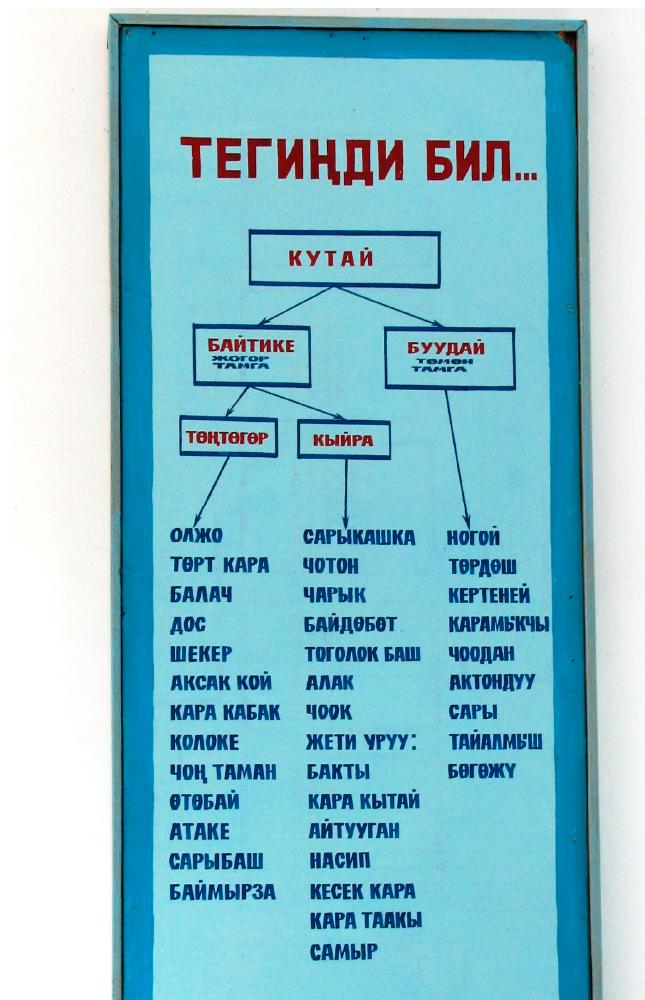
Figure 3. A local sanjïra in the same history classroom as Figure 1: genealogy of “Kutay” with the heading “Know your roots.” This simplified form provides only three levels of descent before simply listing the uruu contained within each group. Here the “jeti uruu” (seven uruu) are squeezed into the bottom of the middle column, similar to Kerimbekov and Sharshenaliev (2008, p. 118), although most sources specify that they descend from the first son of Baytike. The jeti uruu are in fact managed by a single local biy, but treated as separate lineages that can intermarry. Here the list includes Kesek Kara and leaves out Bolku.